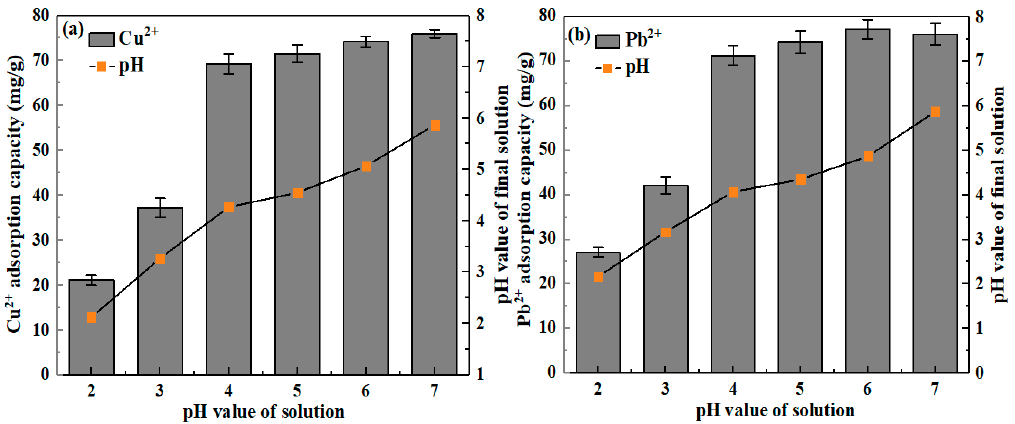
Figure 8. Effect of pH value on 200 mg/L Cu(II) ( a ) and 200 mg/L Pb(II) ( b ) sorption onto CLB, respectively. (adsorbent dose: 0.5 g; solution volume: 200 mL; temperature: 25 ± 1 °C; contact time: 24 (adsorbent dose: 0.5 g; solution volume: 200 mL; temperature: 25 ± 1 ◦ C; contact time: 24 h).